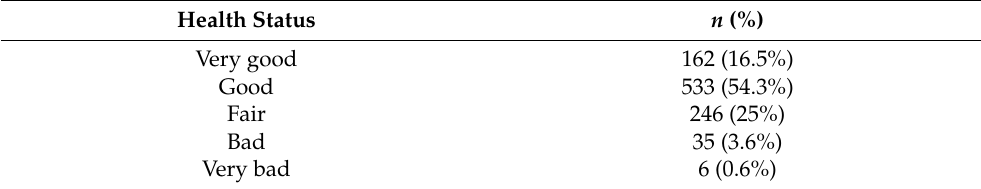
Table 3. Health status ( n = 982).